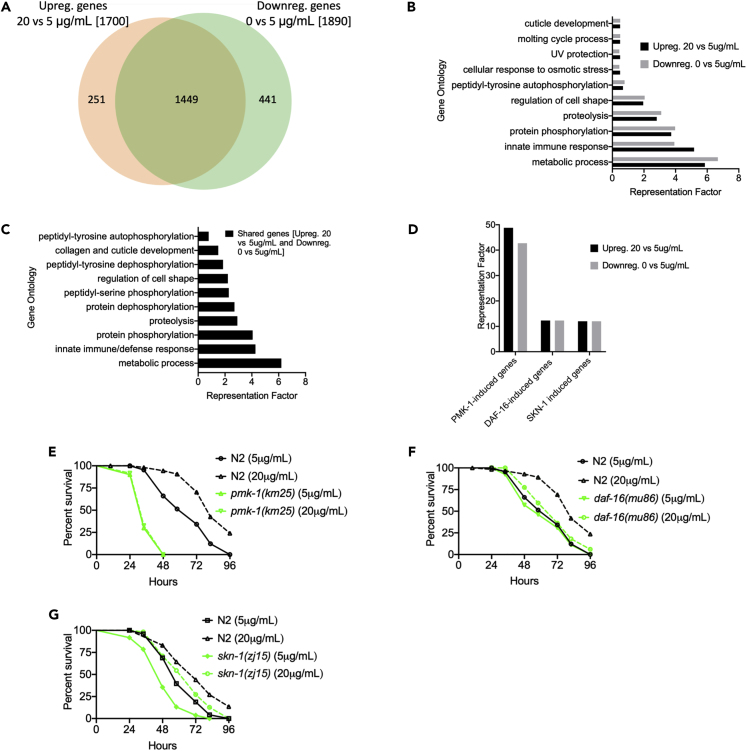
Cholesterol-Mediated Immunity Primarily Acts through a p38/PMK-1 MAPK Pathway(A) Venn diagram showing upregulated genes (20 versus 5 μg/mL cholesterol) and downregulated genes (0 versus 5 μg/mL cholesterol).(B) Gene ontology analysis of upregulated and downregulated genes in animals grown on 20 and 0 μg/mL cholesterol, respectively. The cutoff is based on the filtering thresholds of P < 0.05 and arranged according to the representation factor.(C) Gene ontology analysis of shared genes between animals grown at 20 versus 5 μg/mL and 0 versus 5 μg/mL cholesterol. The cutoff is based on the filtering thresholds of P < 0.05 and arranged according to representation factor.(D) Representation factors of immune pathways for the upregulated and downregulated immune genes in animals grown at 20 versus 5 and 0 versus 5 μg/mL cholesterol, respectively.(E) WT and pmk-1(km25) animals were grown on 20 and 5 μg/mL cholesterol, exposed to P. aeruginosa, and scored for survival. WT animals grown on 5 μg/mL cholesterol (control) versus 20 μg/mL, P < 0.0001; pmk-1(km25) 5 μg/mL, P < 0.0001; pmk-1(km25) 20 μg/mL, P > 0.0001. pmk-1(km25) 0 μg/mL versus pmk-1(km25) 5 μg/mL, P = NS.(F) WT and daf-16(mu86) animals were grown on 20 and 5 μg/mL cholesterol, exposed to P. aeruginosa, and scored for survival. WT animals grown on 5 μg/mL cholesterol (control) versus 20 μg/mL, P < 0.0001; daf-16(mu86) 20 μg/mL, P = NS; daf-16(mu86) 5 μg/mL, P = NS.(G) WT and skn-1(zj15) animals were grown on 20 and 5 μg/mL cholesterol, exposed to P. aeruginosa, and scored for survival. skn-1(zj15) animals grown on 5 μg/mL cholesterol (control) versus 20 μg/mL, P < 0.001.